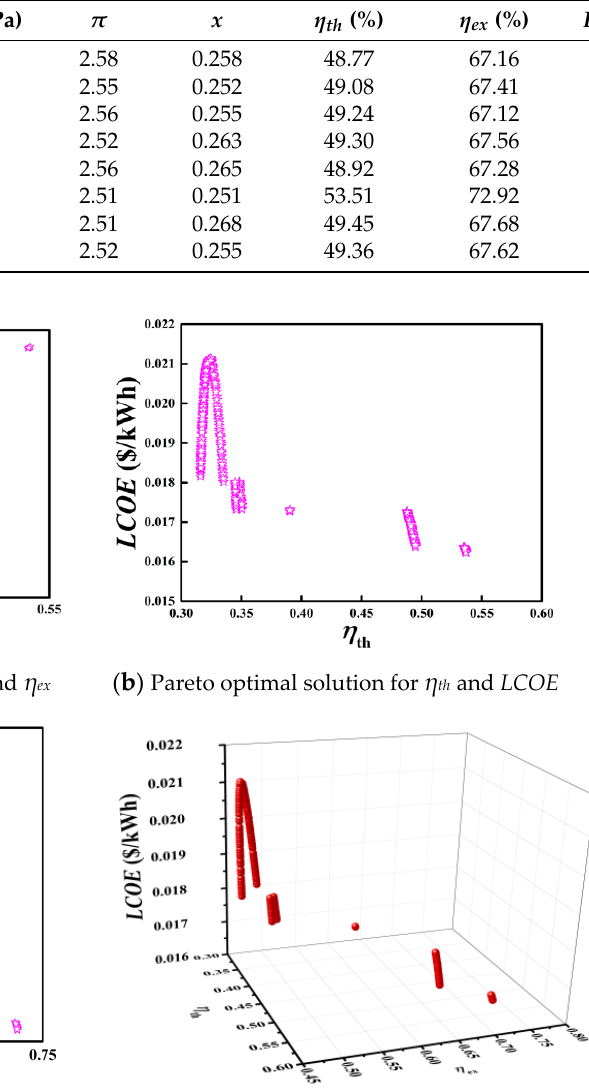
with η th and η ex , η th and LCOE , and η ex and LCOE as the optimization objectives, respec-